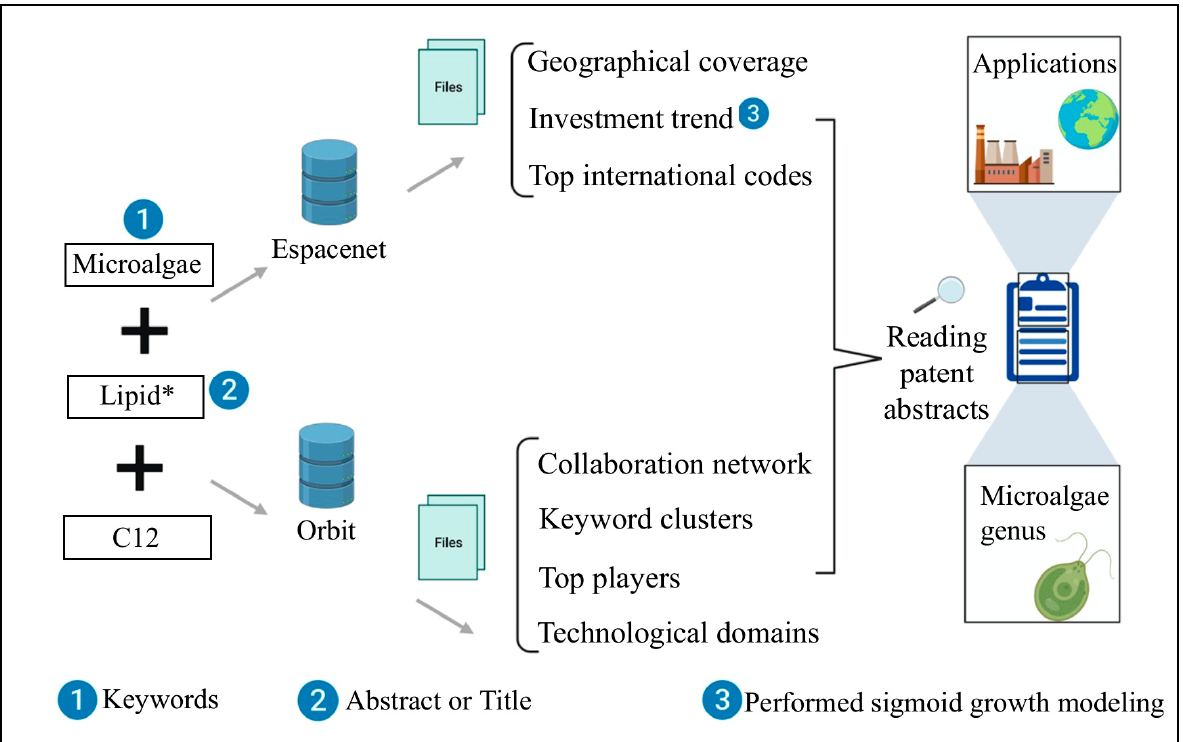
Figure 1. Illustrative scheme of the methodological steps performed. Image created with BioRender. * Truncation symbol representing the sequence of characters of any length.